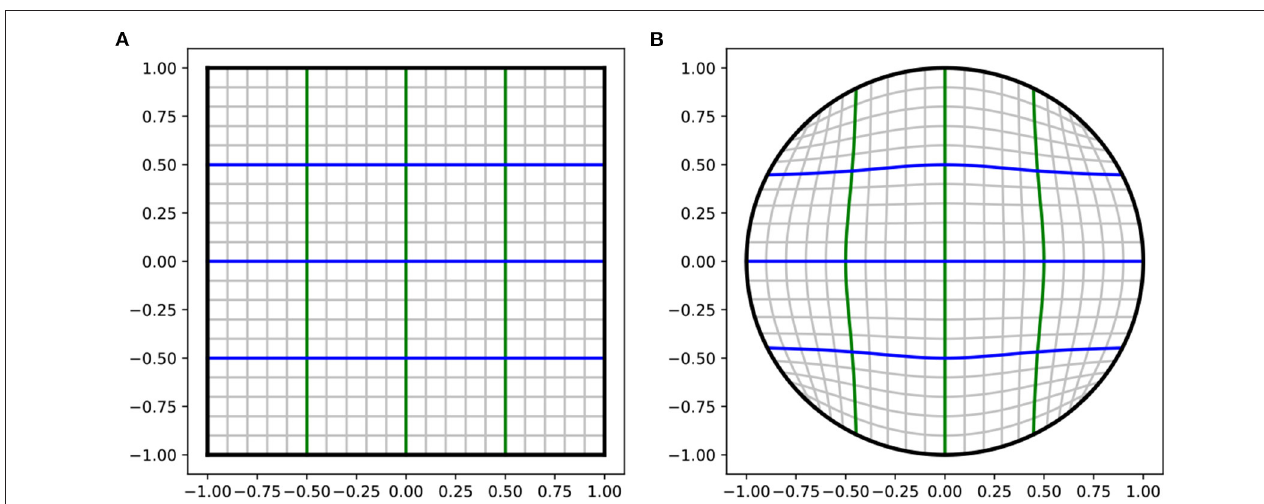
E x ∈ R 2 : | x | < 1, | y | < 1 . (B) Unit circle, mapped from the square using (cid:8) (cid:9)